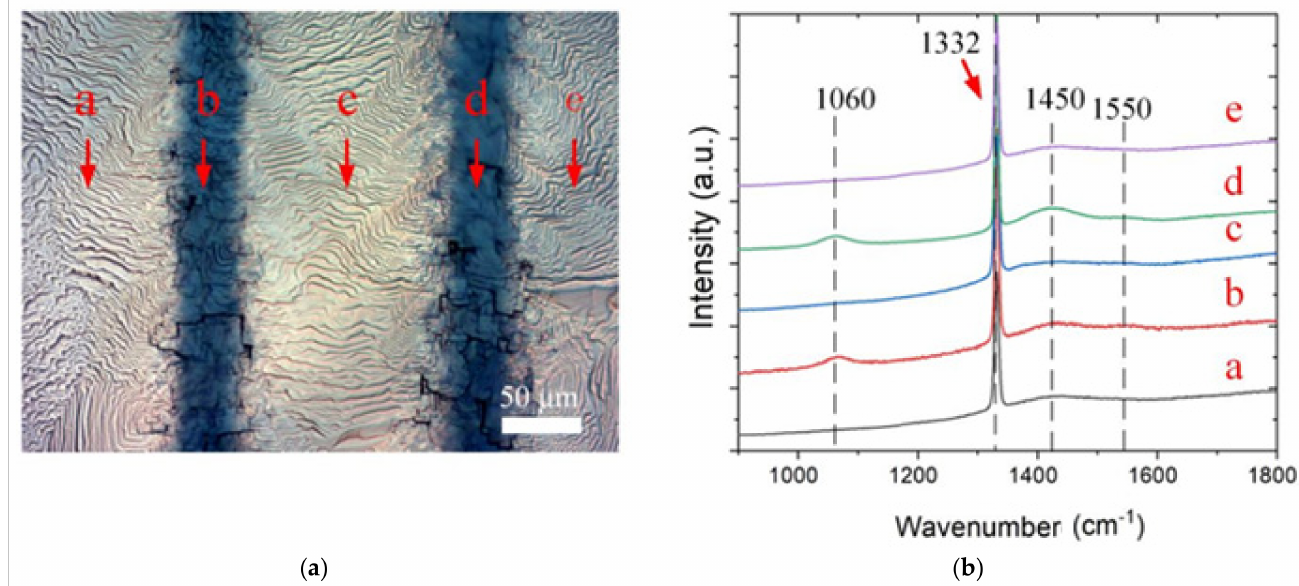
Figure 3. ( a ) After growth of the image; ( b ) Raman spectra taken from different locations around the channel (as shown in the adjacent